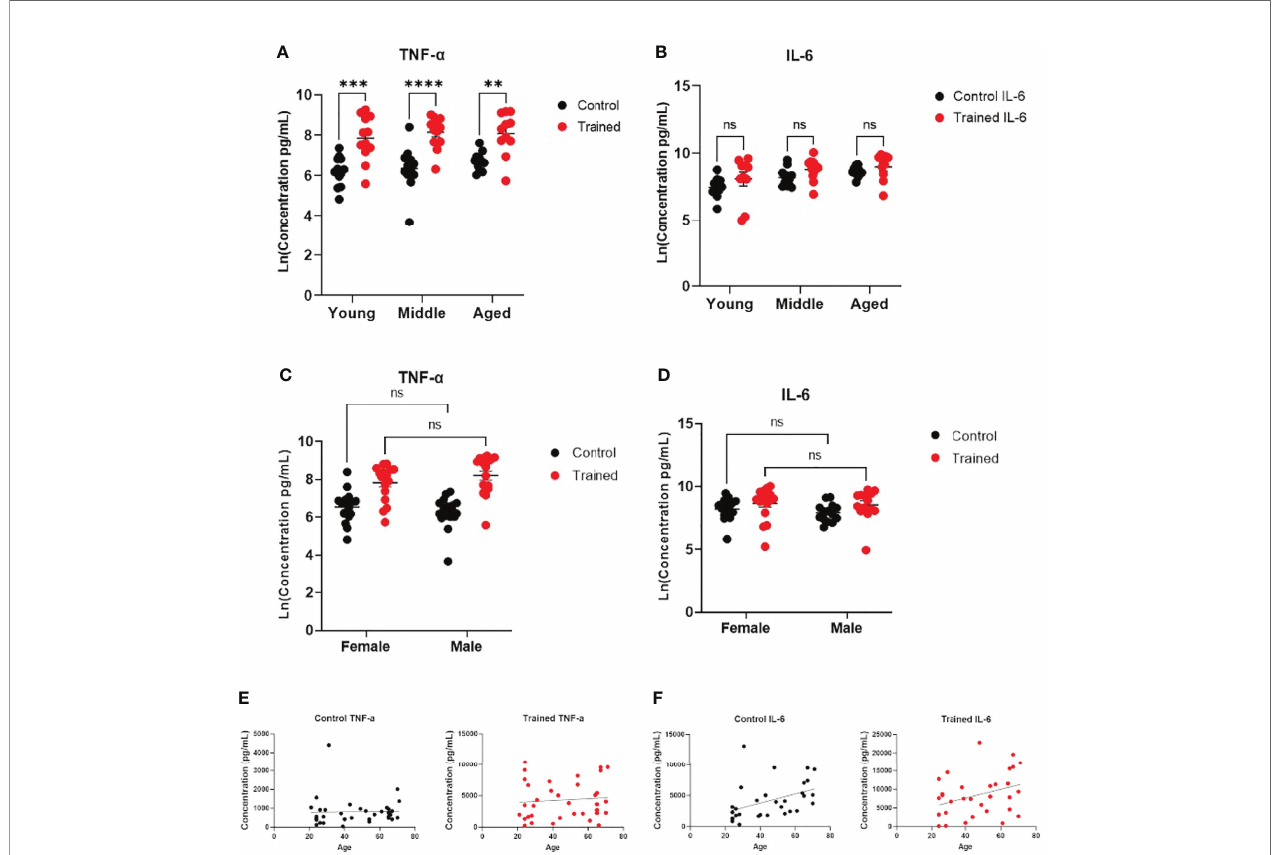
FIGURE 3 | Immune training stimulated increased monocyte cytokine expression. (A) Scatter plot of TNF – a expression 7 days after b – glucan or PBS treatment, followed by LPS (N=11,12). TNF – a expression was below the limit of detection in trained and control monocytes that were not subsequently challenged with LPS. (B) IL – 6 expression (N=10 – 12). IL – 6 expression was limit of detection at baseline. (C) Scatter plot of TNF – a expression after LPS stimulation (10ng/mL) 7 days after b – glucan or PBS treatment (Female: N=18, Male: N=14). (D) IL – 6 expression after LPS stimulation (Female: N=17, Male: N=14). (E) Scatter plot and simple linear regression of TNF – a expression by age in control and trained cells. Correlations are not signi fi cant (N=35). (F) Scatter plot and simple linear regression of IL – 6 expression in trained and control cells. Control cells: R 2 = 0.1792, P=0.0158 (N=32). Trained cells: R 2 = 0.0.1203, P=0.0518 (N=32). A and B measured were analyzed with a mixed effect model and S ̌ ı ́ da ́ k ’ s multiple comparisons test. C and D were analyzed by PERMANOVA for sex and training (**P ≤ 0.01, ***P ≤ 0.001, ****P ≤ 0.0001, ns, not signi fi cant).